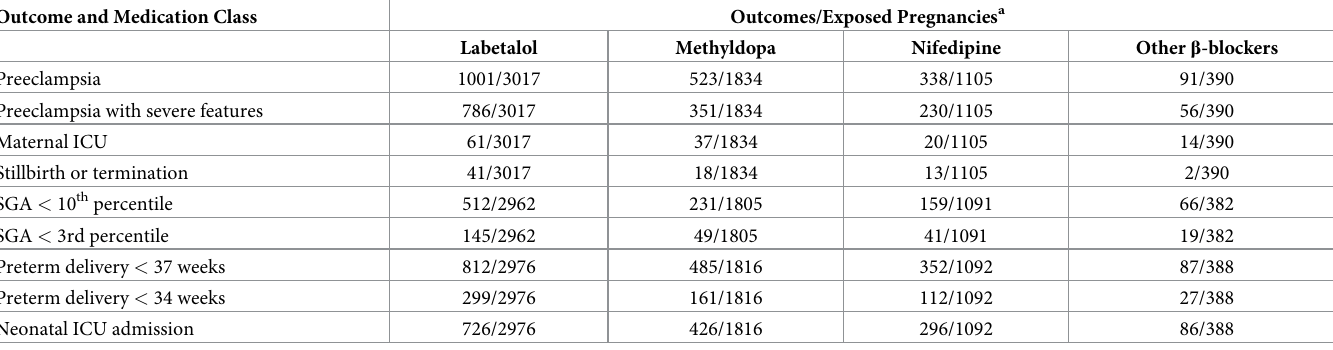
Table 2. Counts of maternal and neonatal outcomes by treatment